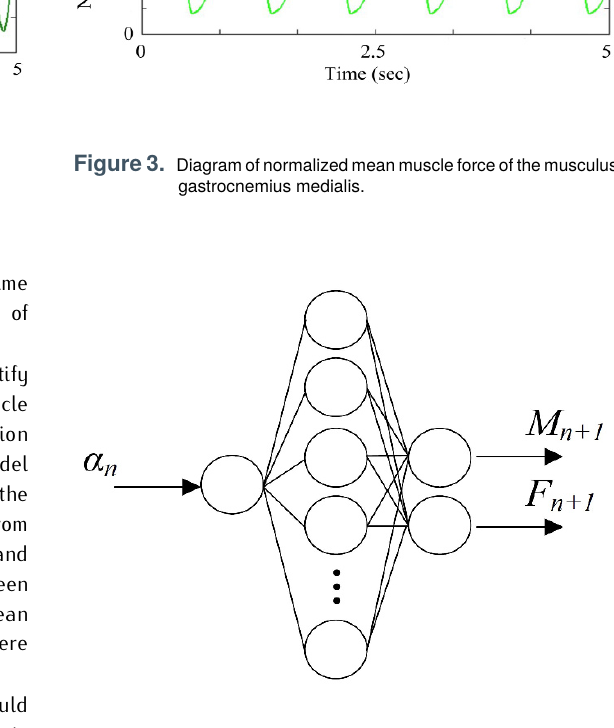
Figure 4. A schematic diagram of the ANN for predicting the muscle moment and muscle